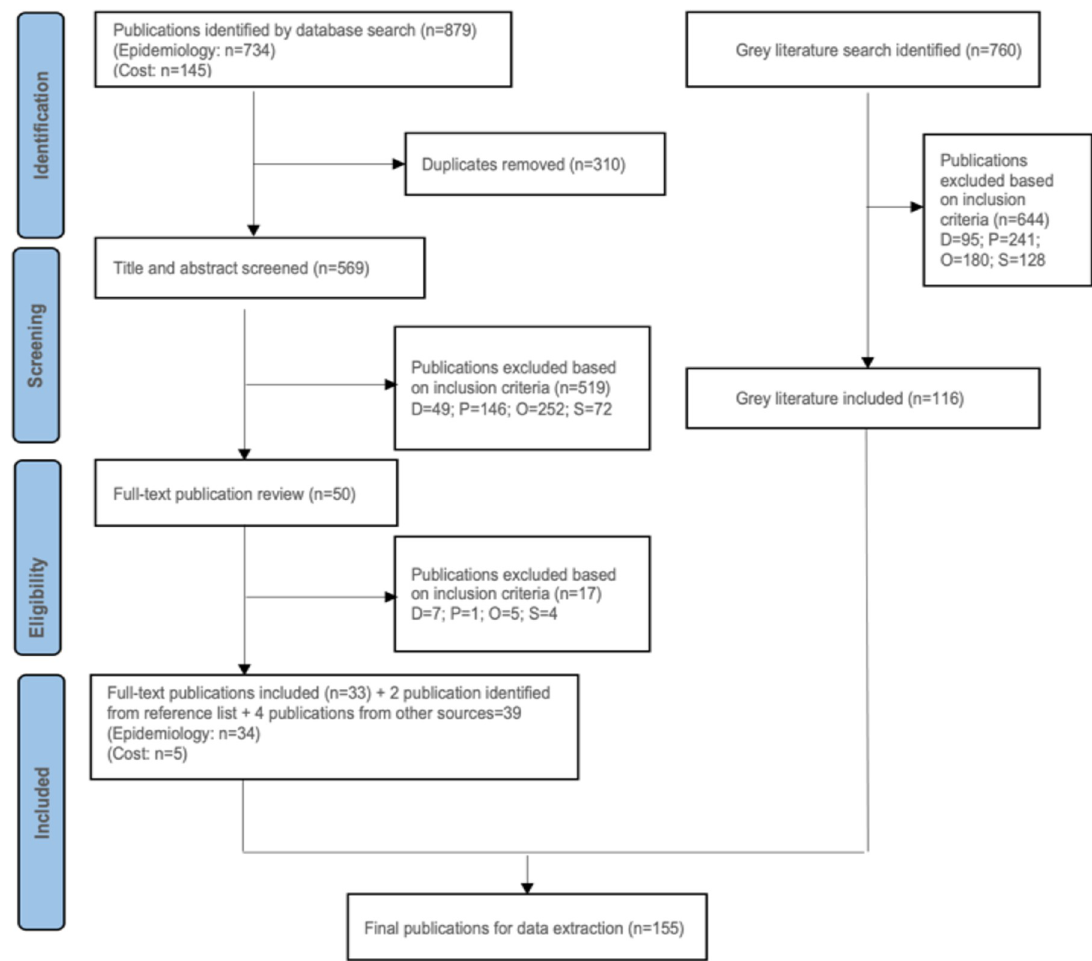
Fig 1. PRISMA flowchart for epidemiology and cost studies. D: duplicate; O: outcome; P: population; S: study design.